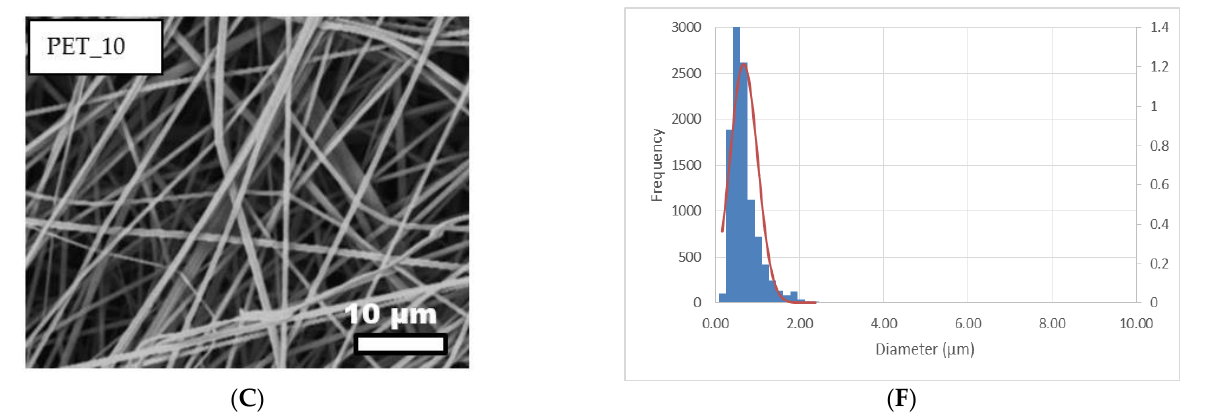
Figure 2. SEM images of electrospun fibers: PET20% ( A ), PET12% ( B ), and PET_10% ( C ), with their respective fiber size distributions ( D – F ).